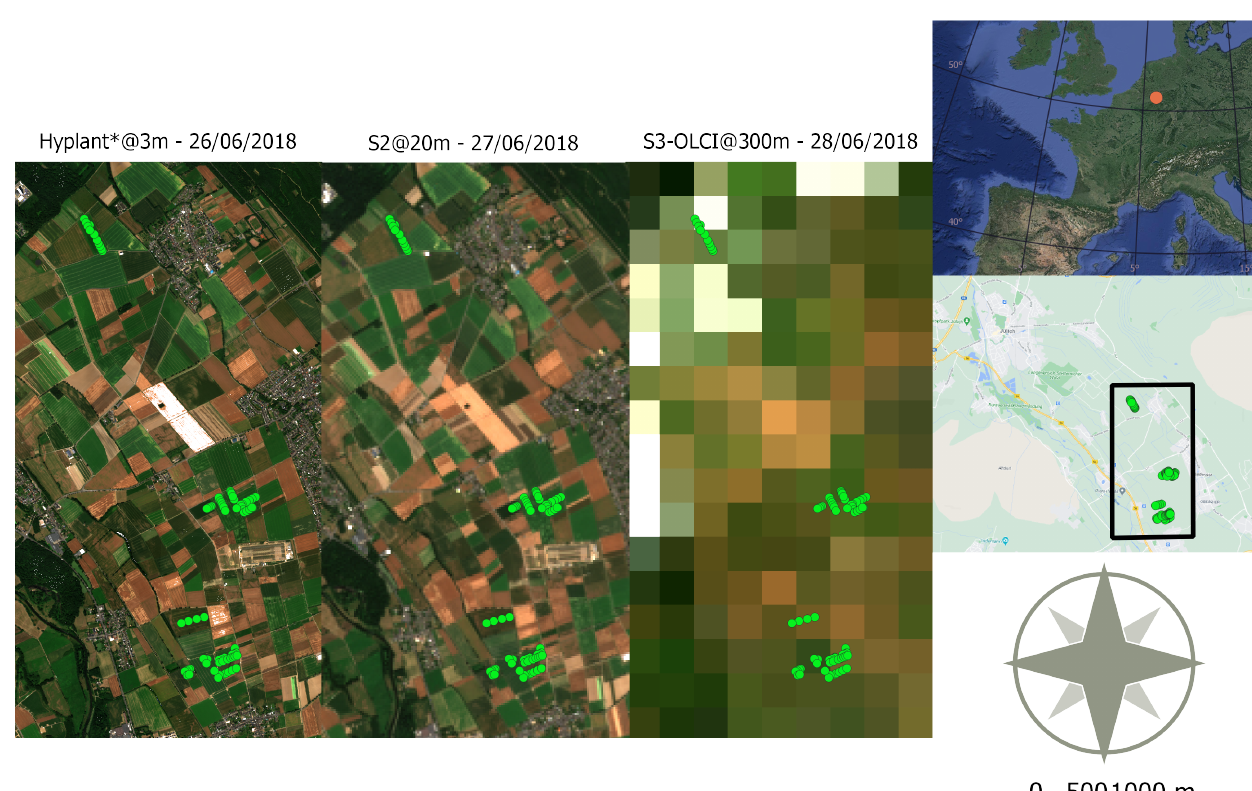
Figure 2. True-color composite (RGB: 665; 560; 490 nm) of the three used remote sensing datasets. ( Left ) the HyPlant* subset with a 3 m spatial resolution, which was resampled to the S3-OLCI spectral resolution (referred to as Hyplant*); ( middle ) the S2 subset with a 20 m spatial resolution; ( right ) the S3-OLCI subset with a 300 m spatial resolution. White pixels represent cloud pixels that were removed within the official S3 processing chain. The red dot on the map at European scale and the green dots on the maps of the study area indicate the localization of the in situ